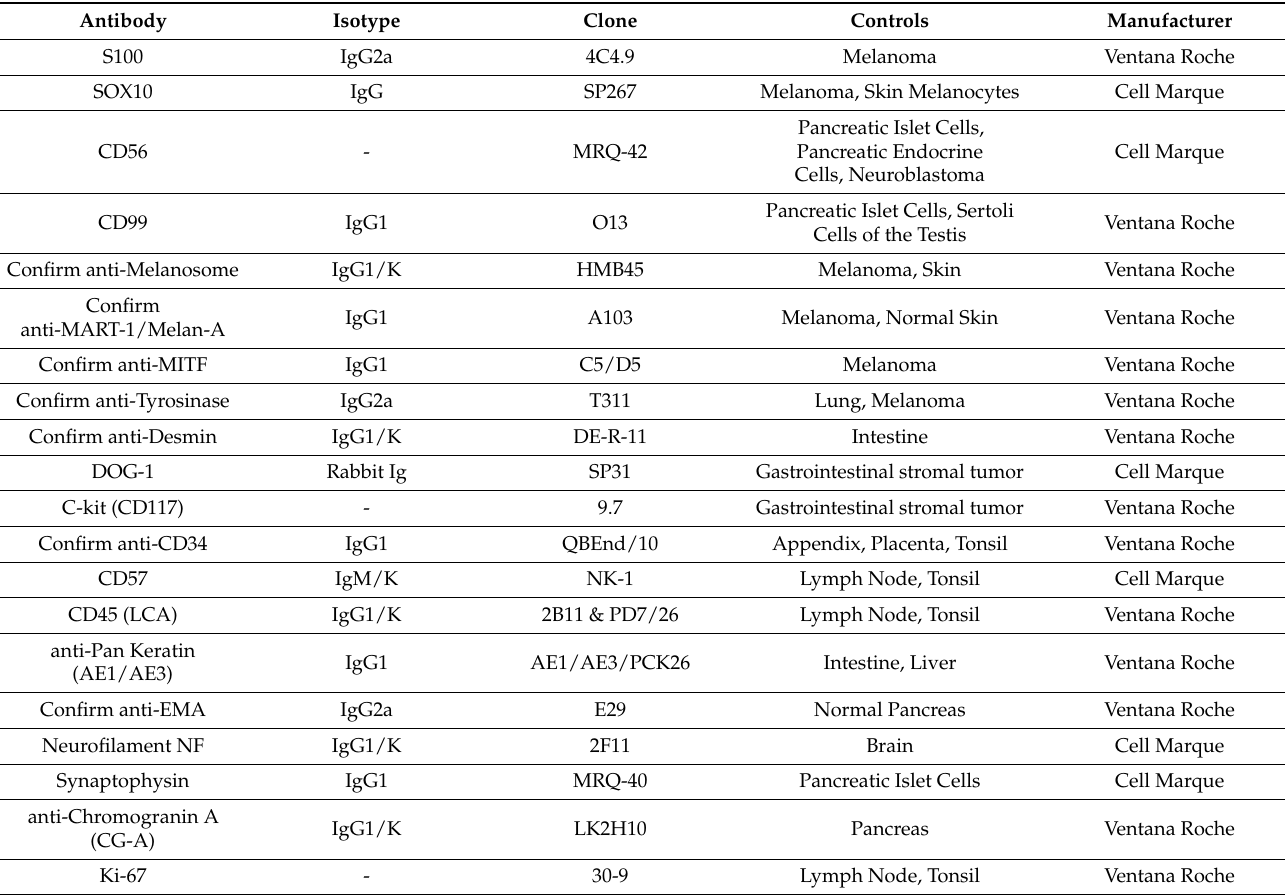
Table 1. Antibodies used for immunohistochemical evaluation.